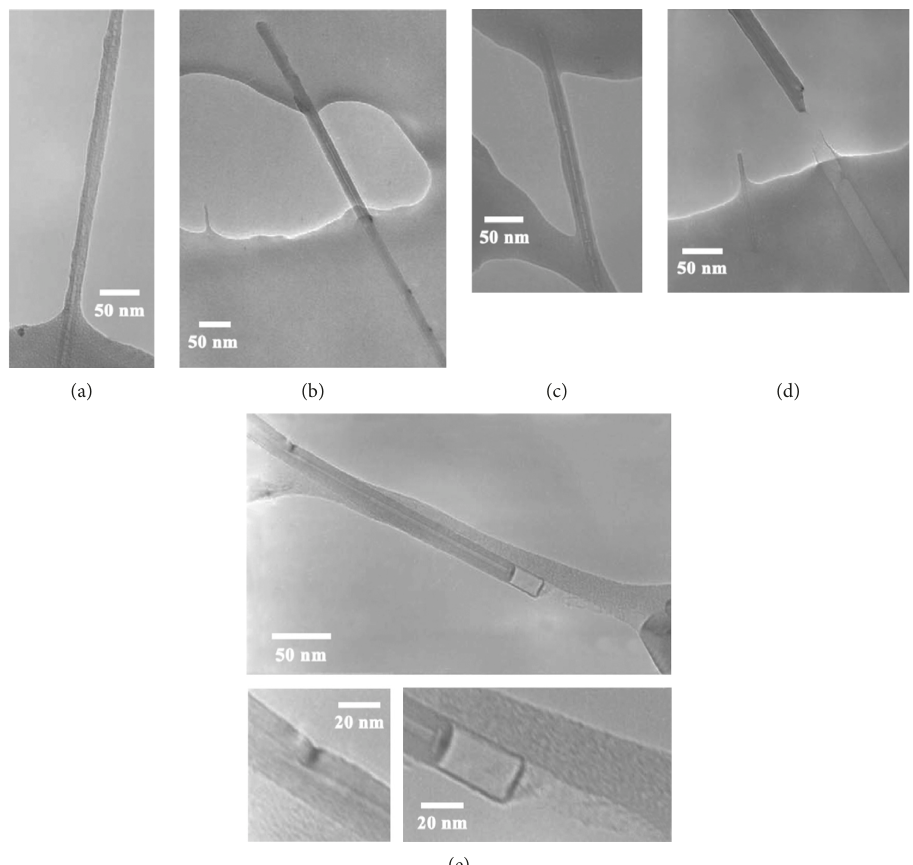
Figure 8: Transmission electron microscope images of an individual, functionalized multiwalled carbon nanotube in an epoxy matrix. (a) Chemically modified carbon nanotube covered by the polymer matrix completely, indicating improved interactions at the interface through a covalent chemical functionalization method. (b and c) Fracture toughness improved by such carbon nanotubes through bridging microcracks and pores in the polymer matrix. (d and e) Evidence of improved interactions at the interface through pull-out tests (adapted with permission from references [168, 169]; copyrights 2003 and 2004, Elsevier